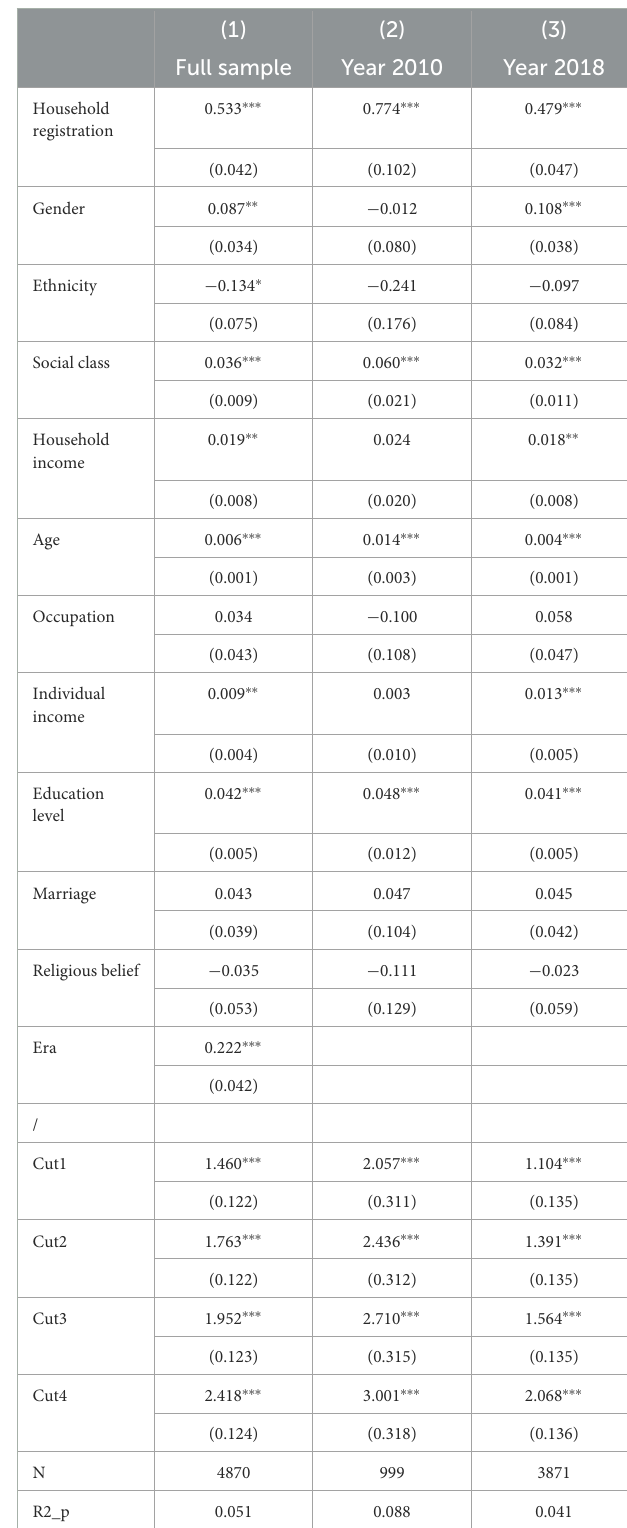
TABLE 6 Benchmark regression. TABLE 7 Robustness test by replacing the dependent